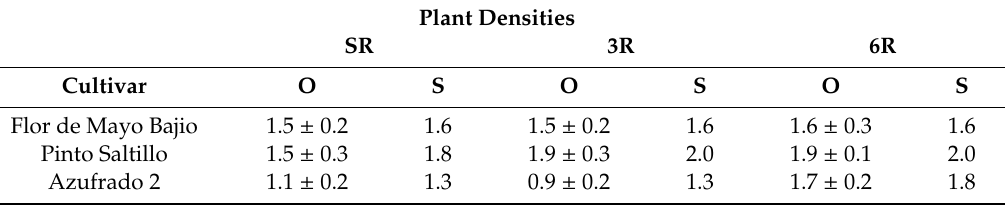
Table 2. Observed (O) and simulated (S) seed yield (Mg ha − 1 ) of common bean cultivars growth habit III Flor de Mayo Bajio and Pinto Saltillo and growth habit I Azufrado 2 planted at seed densities